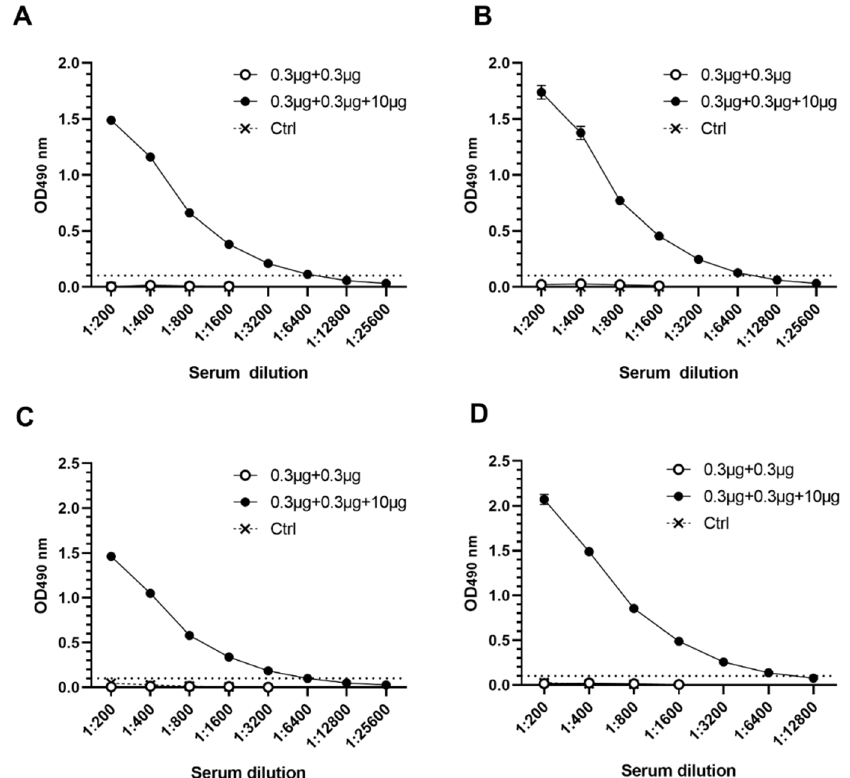
Figure 3. Serum norovirus (NoV)-specific IgG1 and IgG2a subtypes. Pooled termination sera of experimental groups immunized with 0.3 µg NoV GI.4 and GII.4-2006a VLPs alone or mixed with 10 µg VP6, and the control group (Ctrl, PBS only) were two-fold diluted for analyzing NoV ( A , C ) GI.4 and ( B , D ) GII.4-2006a-specific IgG1 and IgG2a. Shown are titration curves with standard error of the mean. Dashed line indicates positivity cut-off (OD ≥ 0.1).